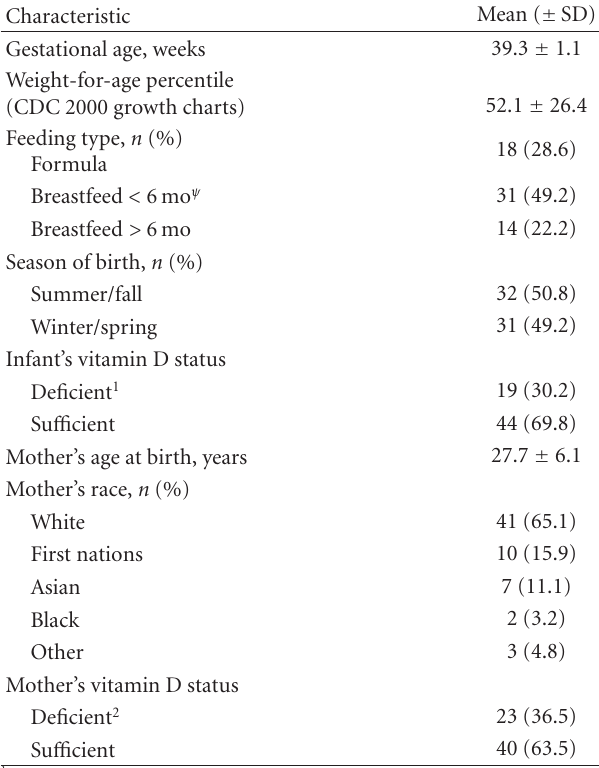
Table 2: Infant and maternal